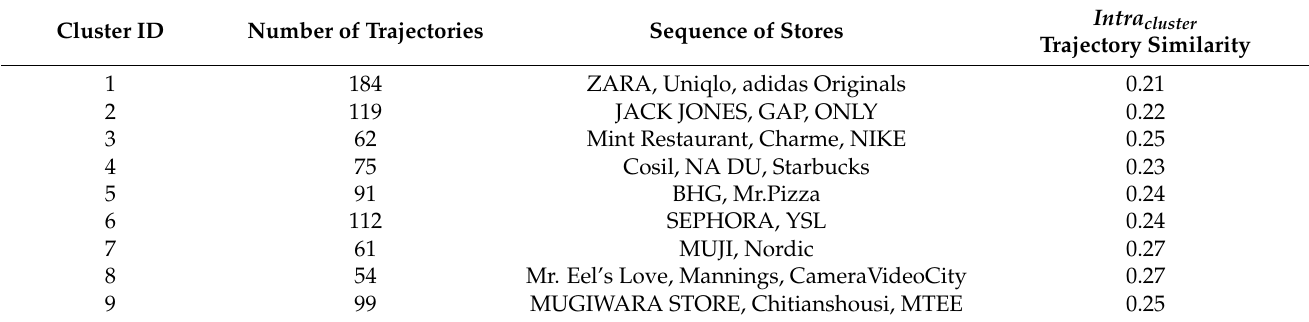
Table 12. Main characteristics of E-DBSCAN clustering